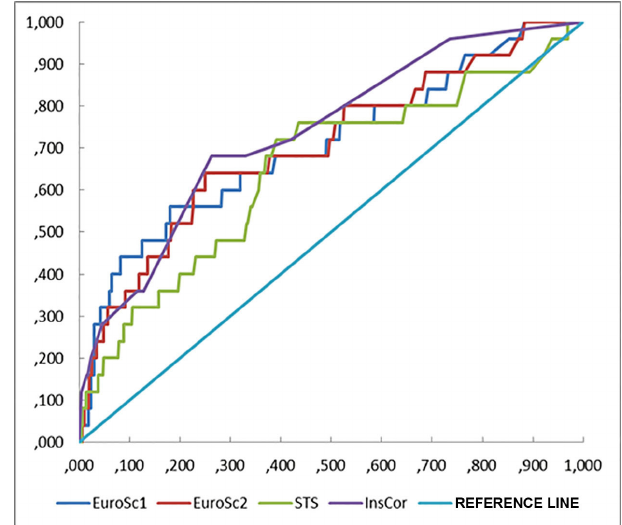
Fig. 1 - ROC curve for the Eurosc1, Eurosc2, STS-score and InsCor. EuroSc1 ROC=ROC curve presented by EuroSCORE score; EuroSc2 ROC=ROC curve presented by EuroSCORE II score; STS ROC=ROC curve presented by STS-score score; InsCor ROC=ROC curve presented by InsCor